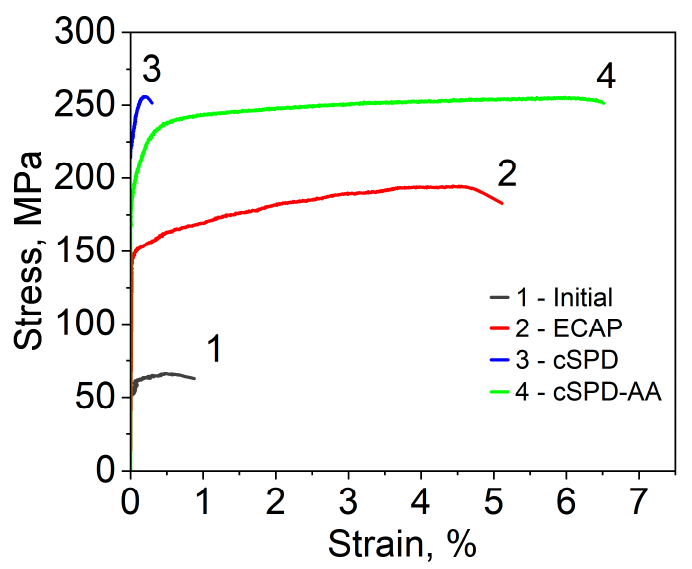
Figure 5. Engineering “stress–strain” curves for the Mg-2Sr alloy in different structural states. Table 2. Mechanical properties of the Mg-2%Sr alloy after different